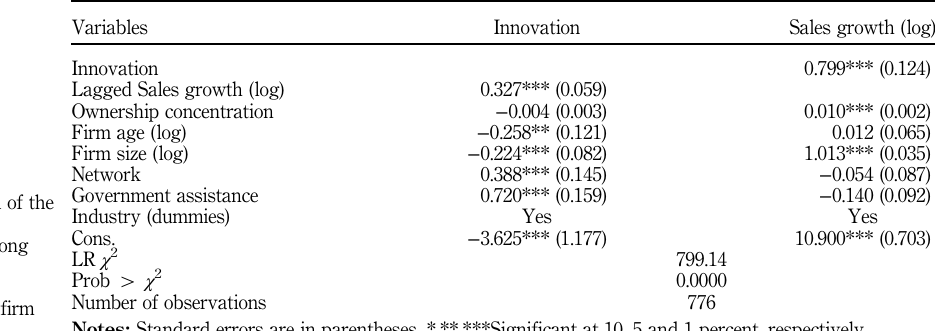
Table II. CMP estimation of the simultaneous relationship among ownership concentration, innovation and firm